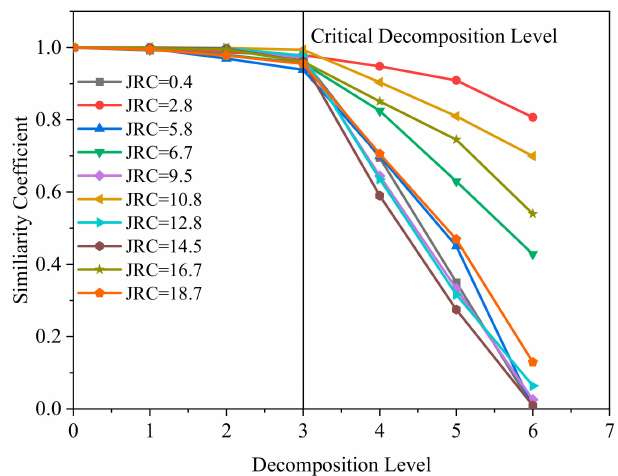
Figure 4. The coefficient of similarity between the approximate component and the initial